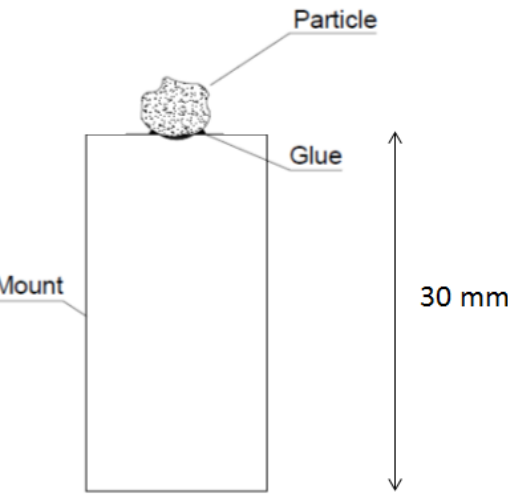
Figure 9. Schematic illustration of grain–brass mount system (after Senetakis et al. [6] with modifications by the authors).